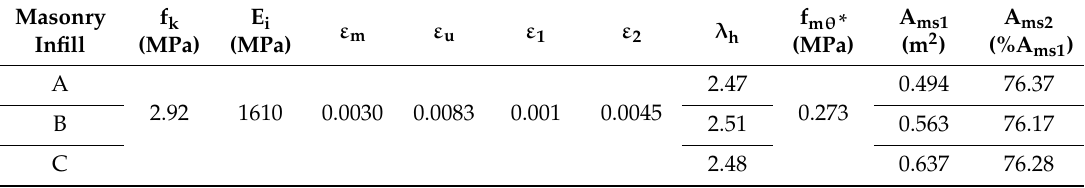
Figure 5. Stress-strain relation for masonry axial compression and the definition of limit states corresponded to the variability of areas and related axial strain. Table 7. Material and geometric properties for nonlinear FEM model of masonry infill.